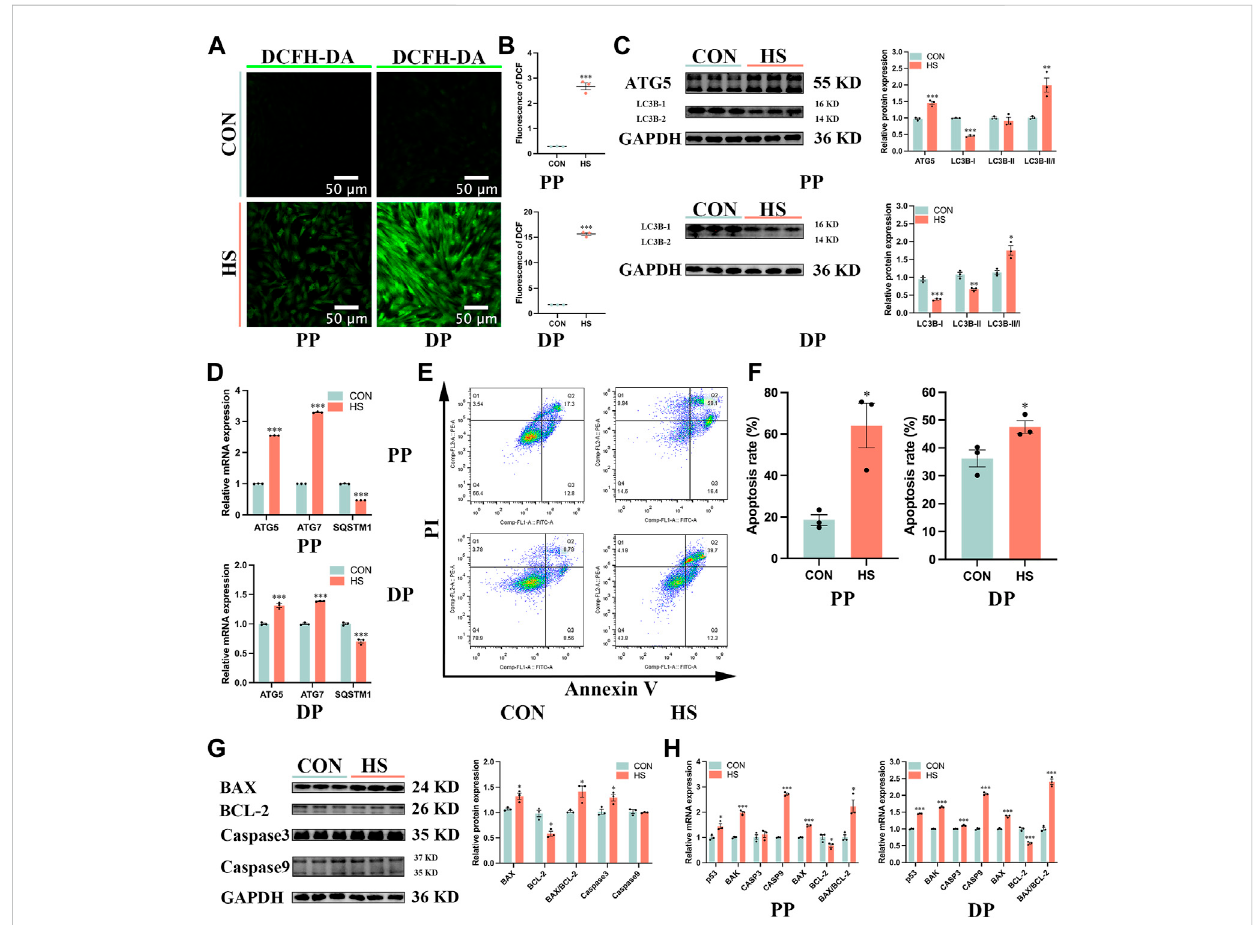
FIGURE 5 Heat stress accelerated the autophagy and apoptosis of myoblasts. (A) The fl uorescent images of myoblasts stained by DCFH-DA probe during proliferation and differentiation. Scale bar, 50 μ m. (B) The fl uorescence levels of DCFH-DA. (C) Protein expression of autophagy in myoblasts during proliferation and differentiation. (D) mRNA expression of autophagy in myoblasts during proliferation and differentiation. (E) The apoptosis of myoblasts during proliferation and differentiation was determined by fl ow cytometry. (F) The apoptosis rate of myoblasts was detected by fl ow cytometry. (G) Protein expression ofapoptosis in myoblasts during proliferation. (H) mRNA expression of apoptosis inmyoblasts during proliferation and differentiation. All data are shown as the mean ± SEM (n = 3, * p < 0.05; ** p < 0.01, *** p <